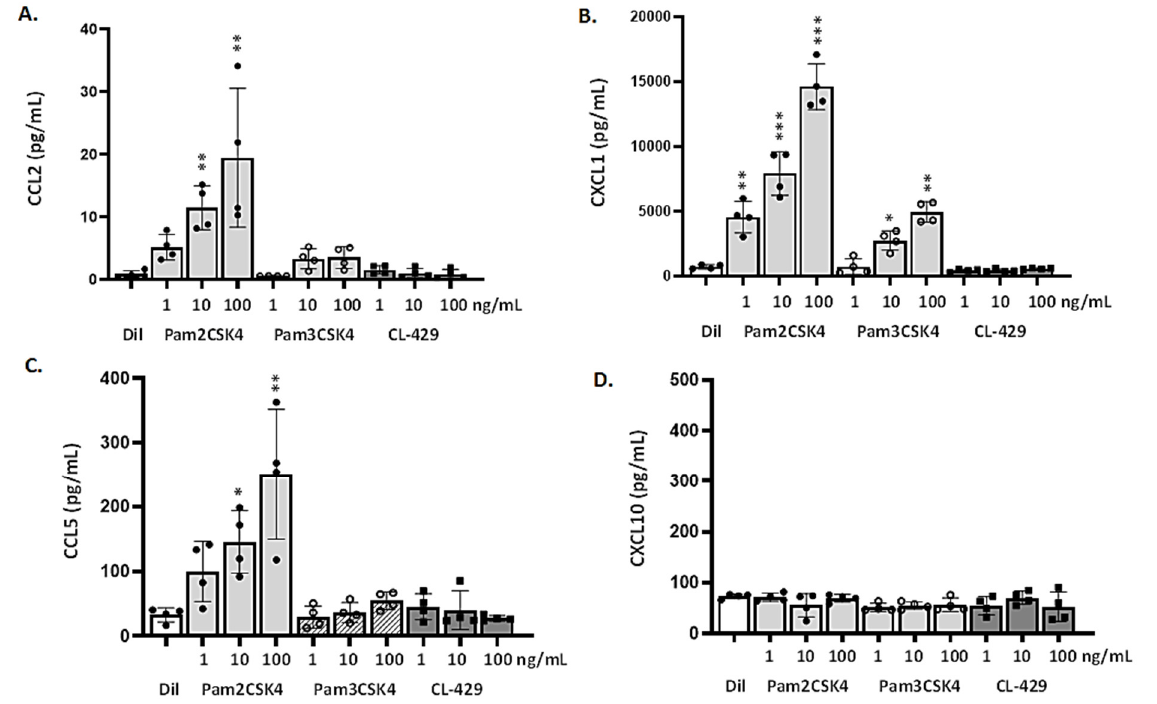
Figure 5. mTECs exhibit distinct responses to the TLR2 agonists Pam2CSK4, Pam3CSK4, and the combined TLR2-MDP ligand, CL-429. mTECs release proinflammatory mediators, including ( A ) CCL2, ( B ) CXCL1, and ( C ) CCL5, but not ( D ) CXCL10, at 48 h after treatment for 2 h with the TLR2/1 ligand Pam2CSK4. Minimal responses were observed in response to administration of Pam3CSK4 (production and release of CXCL1 only). No responses were observed to CL-429 or in response to the NOD2 ligands MDP and L18-MDP (data not shown). All biochemical ligands were added to cultures at final concentrations of 1, 10, or 100 ng/mL. * p < 0.05, ** p < 0.01, or *** p < 0.001 vs. diluent alone, one-way ANOVA.